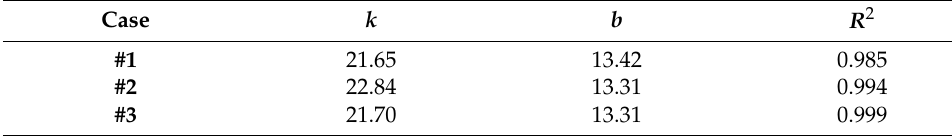
Figure A5. Initial linear stage fitting of the hysteresis loop experiment. Table A2. Linear fitting results of the cases. Case